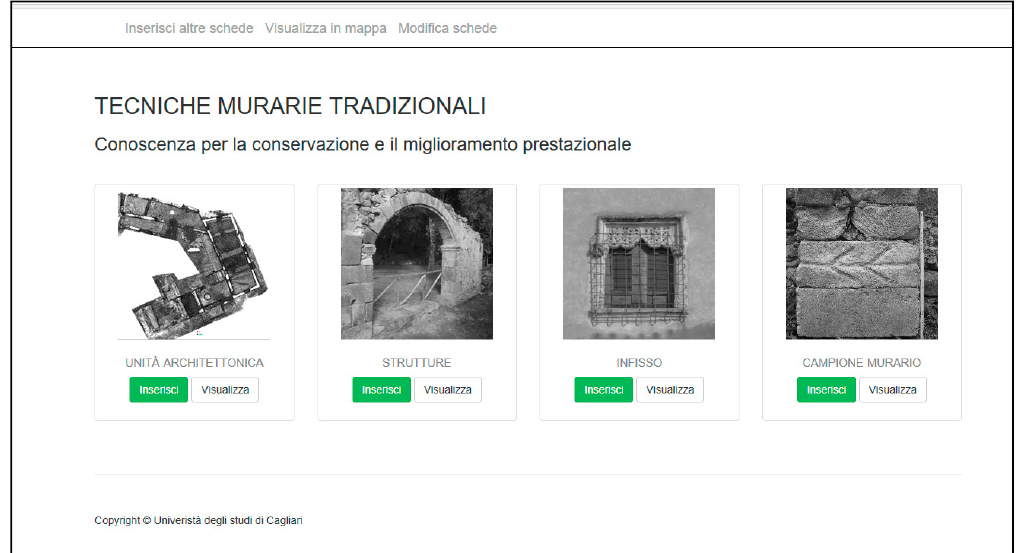
Figure 3. The Geodatabase Start Page.